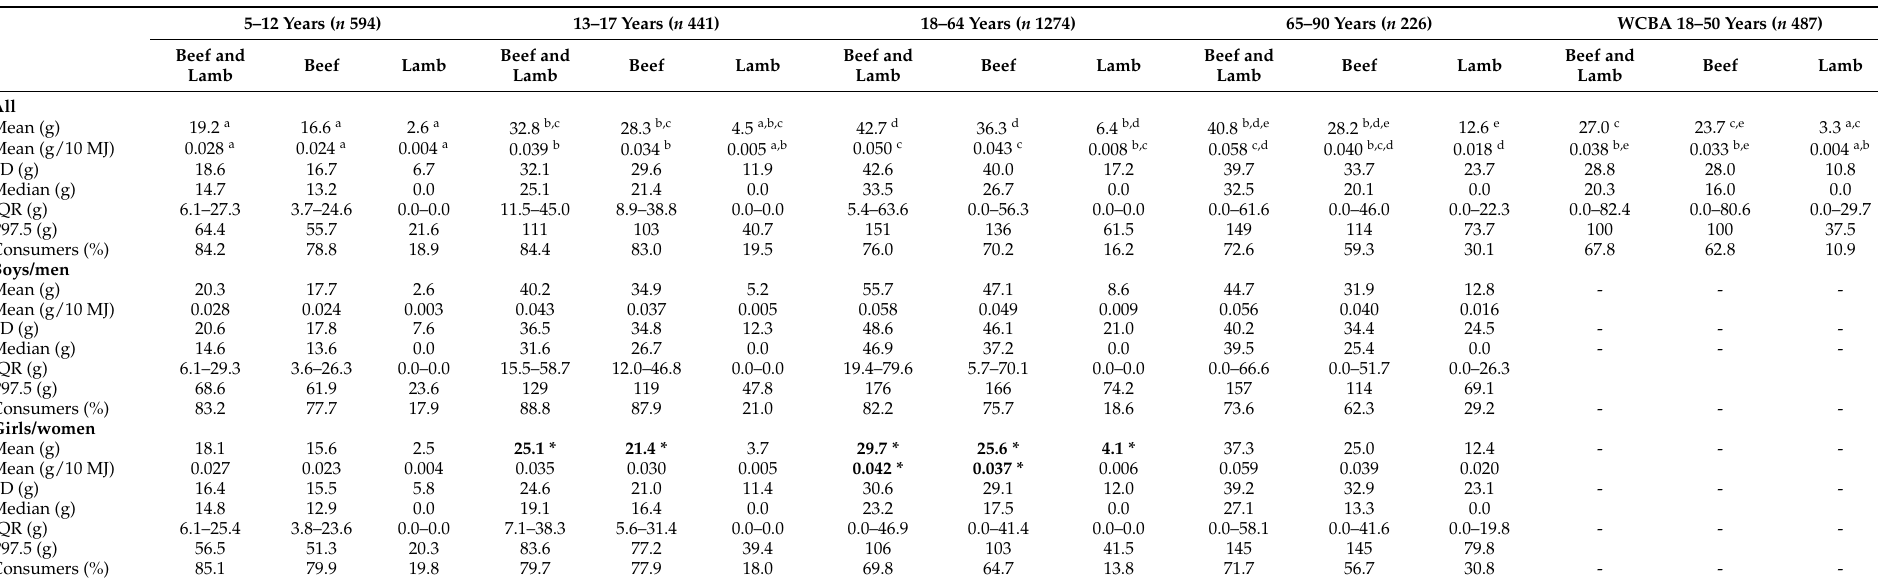
Table 1. Proportion of consumers (%) and mean daily intakes (g/d) of ‘fresh beef and lamb’, ‘beef’ and ‘lamb’ for the total population aged 5–90 years, by age group and